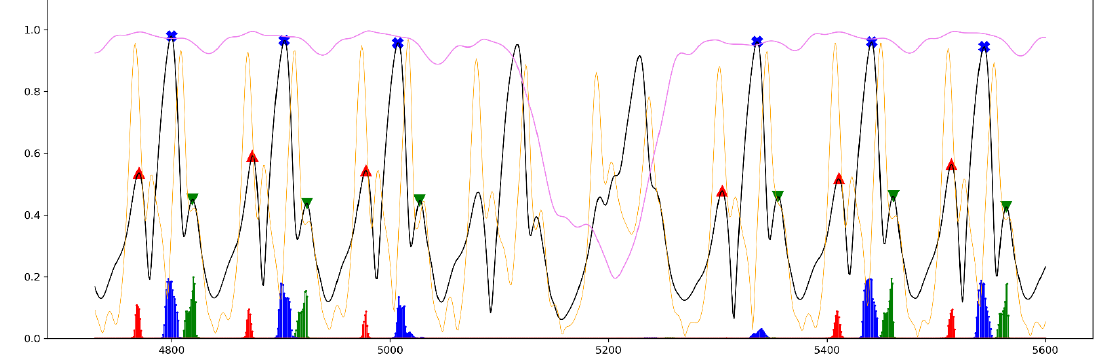
Figure 7. A short part of the evaluation results from Test_1_G. This figure shows six steps while walking straight forward, turning at the end of the walking track, and then walking back. Black line: smoothed AngVelMag; orange line: smoothed FreeAccMag; violet line: smoothed RotMatMag, red markers: labeled FO; red vertical lines: predictions for FO; blue markers: labeled MidS; blue vertical lines: predictions for MidS; green marker: labeled FC; green vertical lines: predictions for FC.